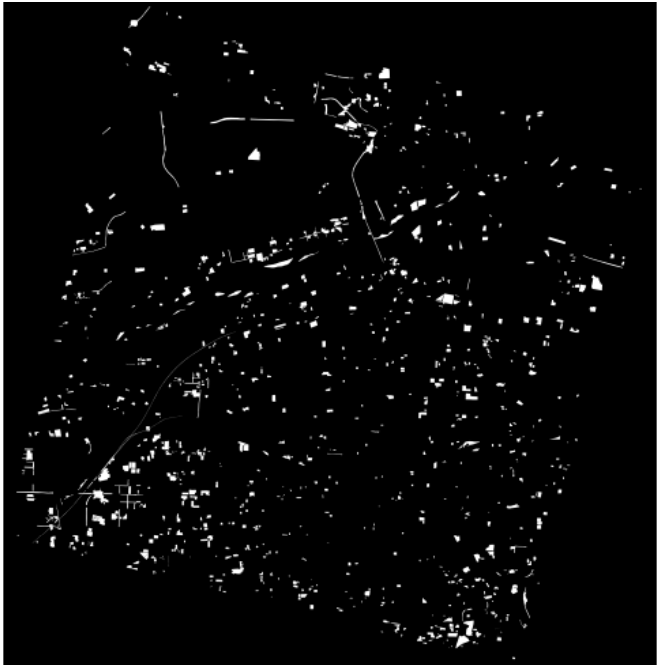
Figure 2. Ground truth changed label. Changed pixels are shown in white, and unchanged pixels are shown in black. Figure 3. The image blocks numbered 8, 12, 14, 15, and 17 were selected as the testing images. The other image blocks were cropped to 224, and the cropping overlap was set to 150